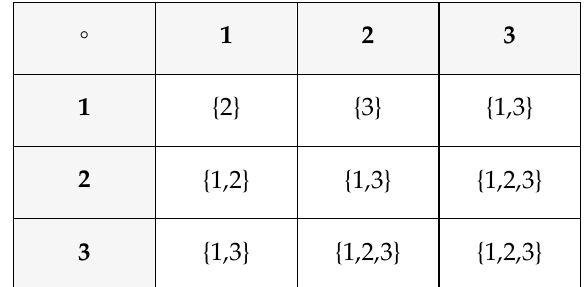
Table 4. Right almost-hypergroup.